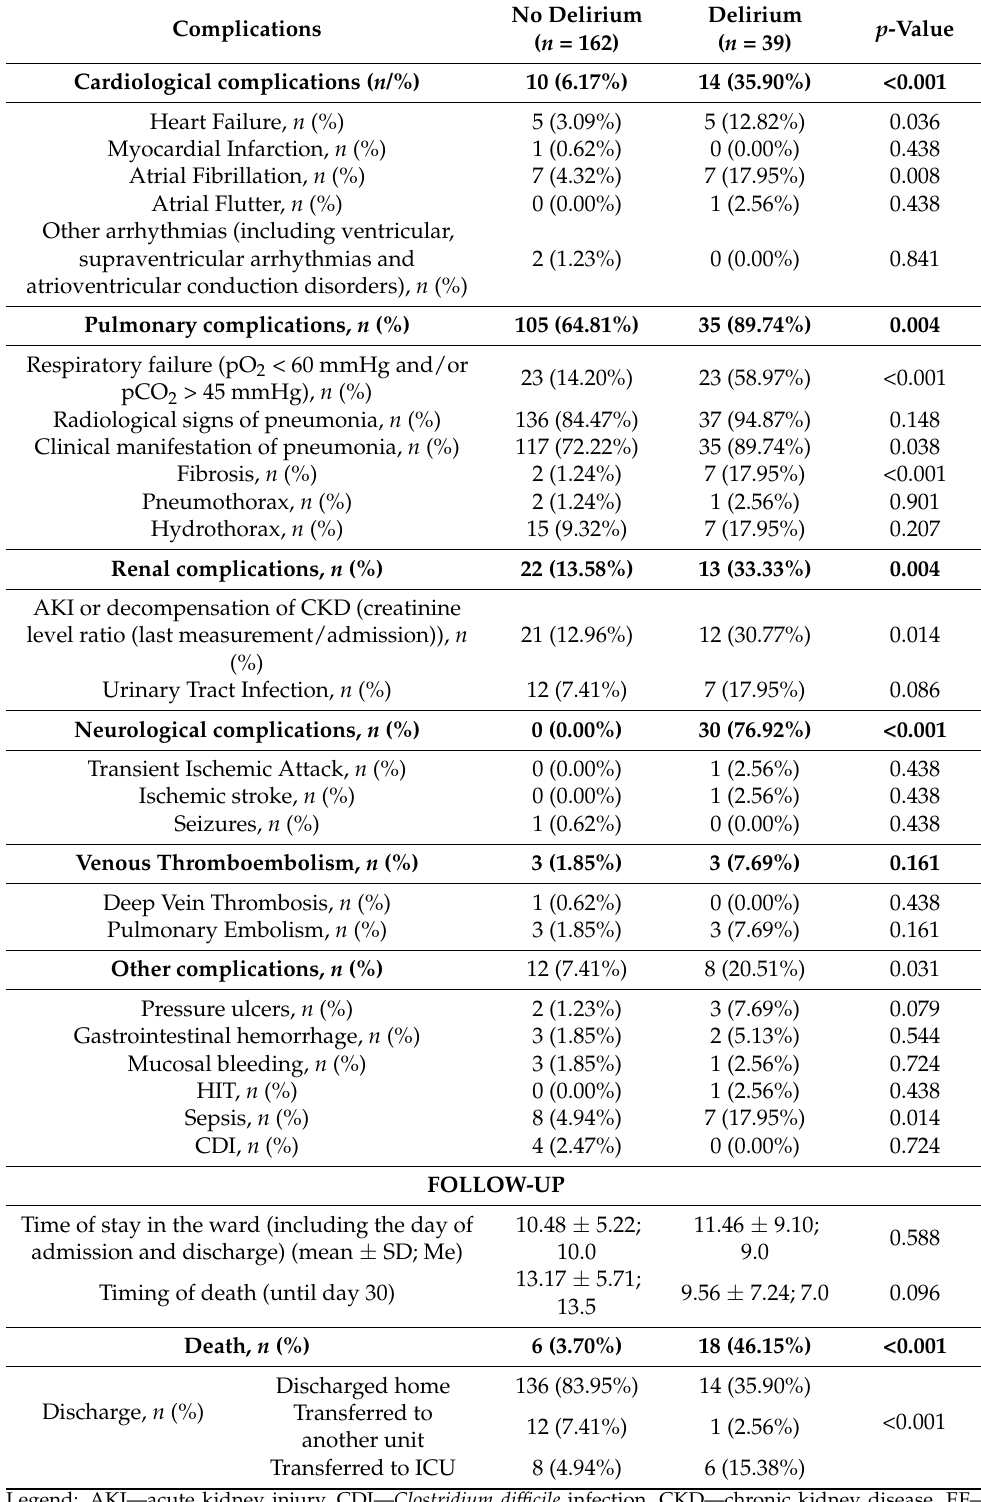
Table 7. Complications and follow-up in COVID-19 patients with and without